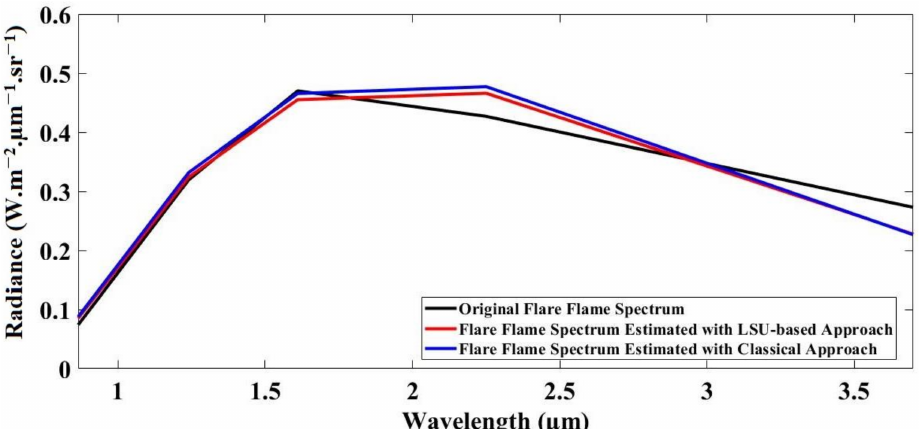
Figure 8. Original flare flame spectrum and its estimates, obtained with the tested approaches, from synthetic data generated with a temperature = 1550 Kelvin and an emissivity = 1.55 × 10 − 5 . Obtained values of the considered criteria for that case with the classical approach are SAM = 5.4502 ◦ and NMSE = 14.0294%, while these values with the designed unmixing-based approach are SAM = 2.3734 ◦ and NMSE = 12.1465%.